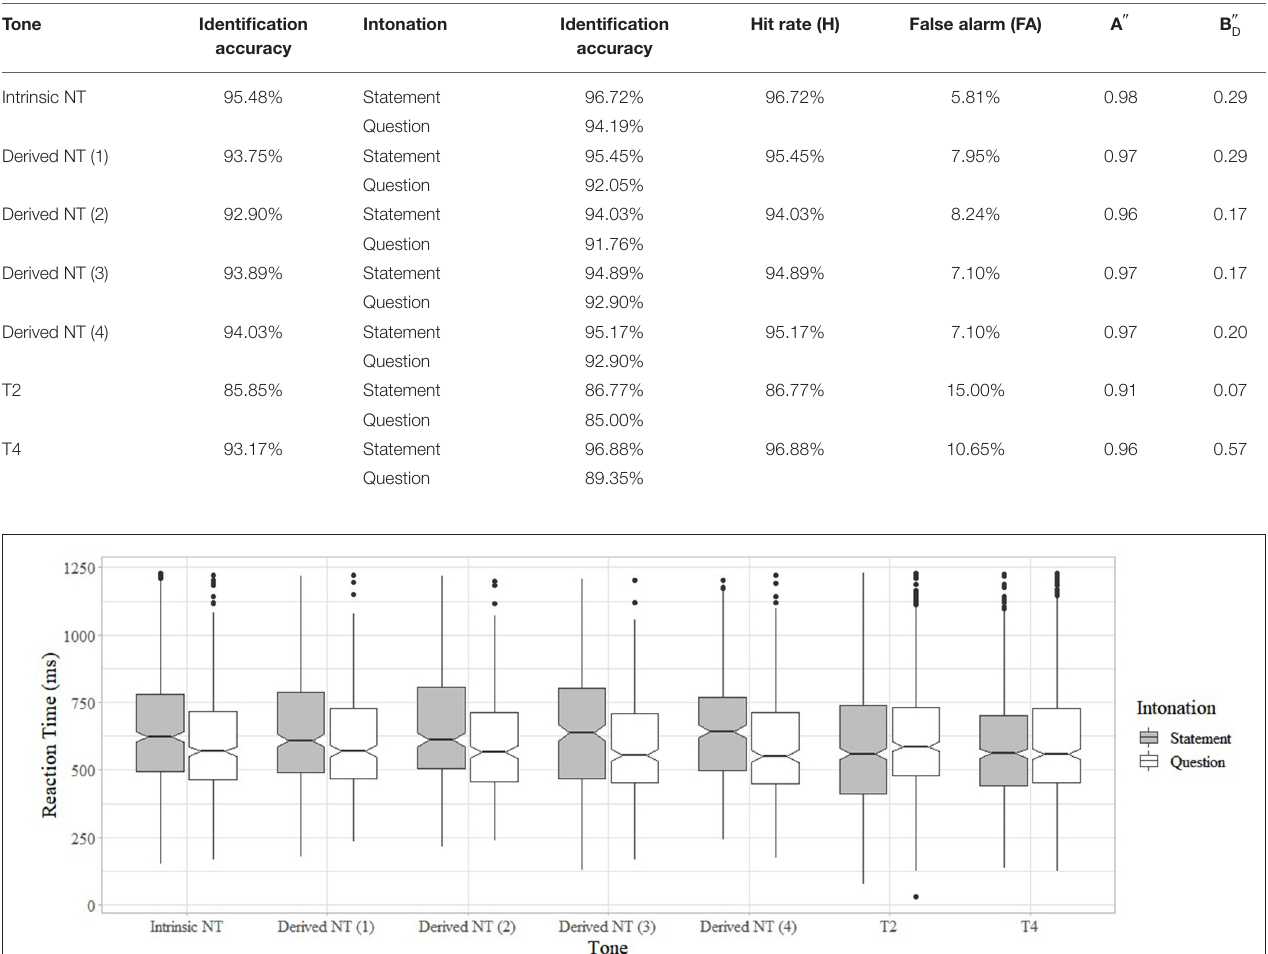
TABLE 4 | Identification accuracy, hit rate (H, i.e., the identification accuracy of statement intonation), false alarm (FA), discriminability (A ′ ) and Bias (B ′′ D ) in each tone condition.